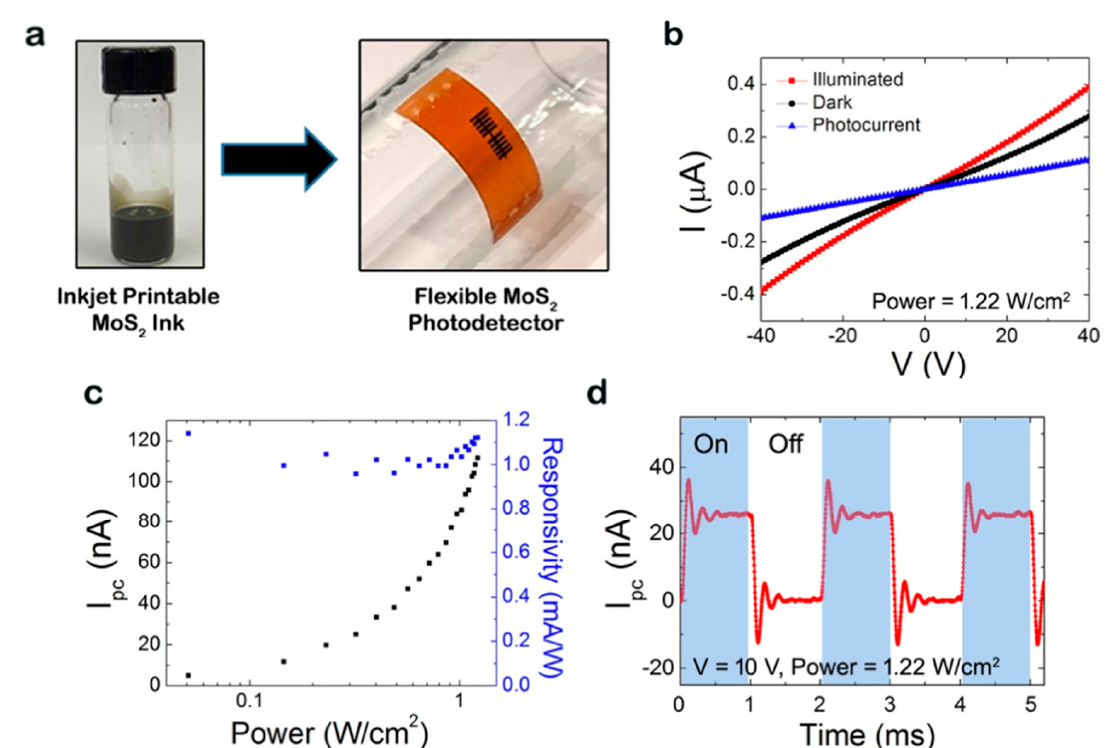
Figure 11. ( a ) Inkjet printable MoS 2 ink and its flexible photodetector. ( b ) Current-voltage curves of the MoS 2 -Gr photode- tector showing the dark and illuminated currents and its photocurrent. ( c ) Photocurrent and responsivity as a function of intensity at a bias. ( d ) Current modulation response at 10 V switching on and off the laser (adapted with permission from ref. [162] Copyright © 2021, American Chemical Society.